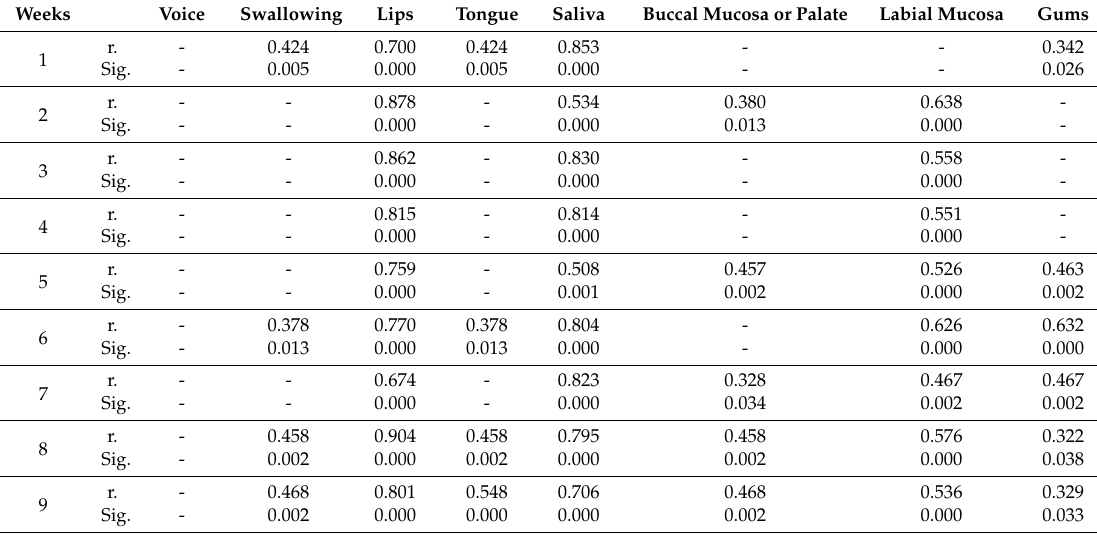
Table 5. Correlations between the total score obtained for oral mucositis and the Oral Assessment Guide items during the 10 weeks of